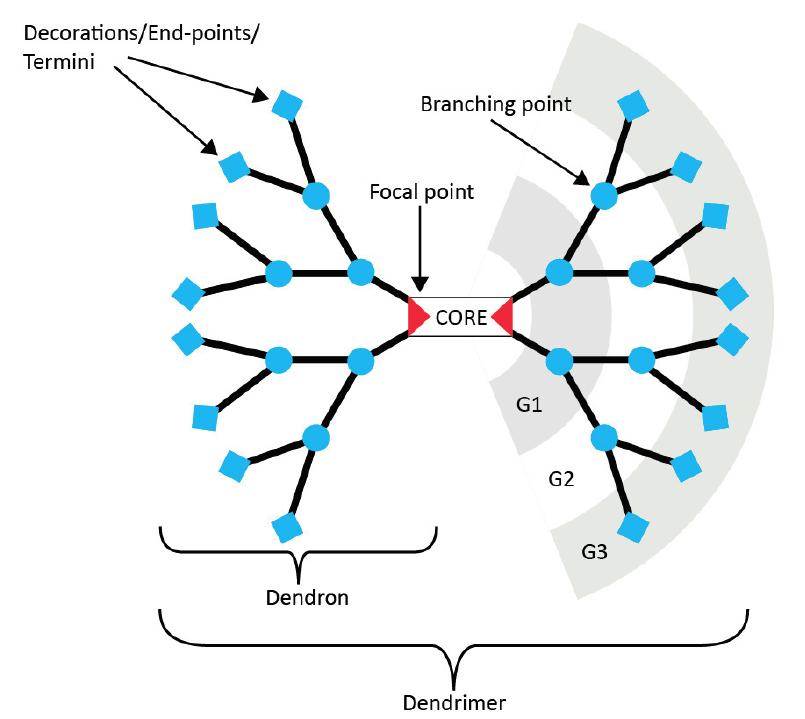
Figure 1. Anatomy of a dendrimer. This example is an AB 2 type, where each branch is made of a monomer A that splits into two B monomers. “G” stands for